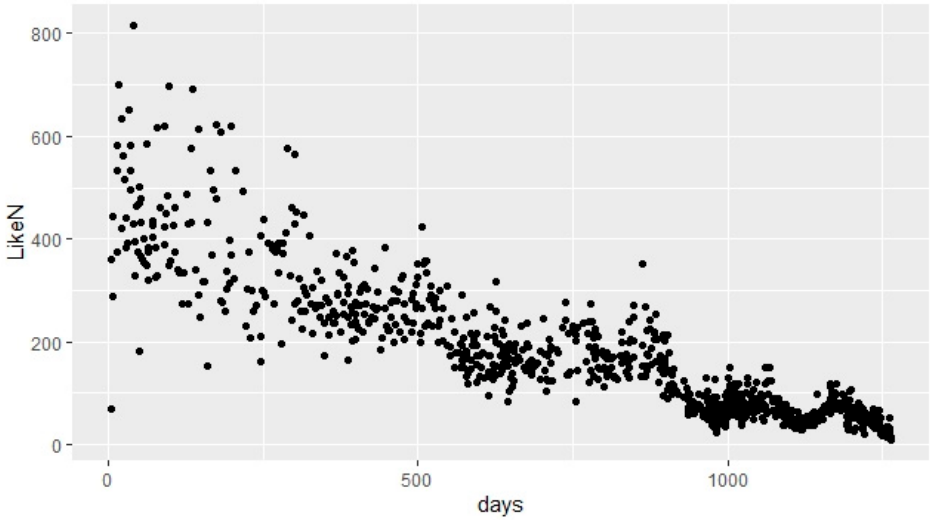
Figure 3. Correlation between days and the number of “Likes”.